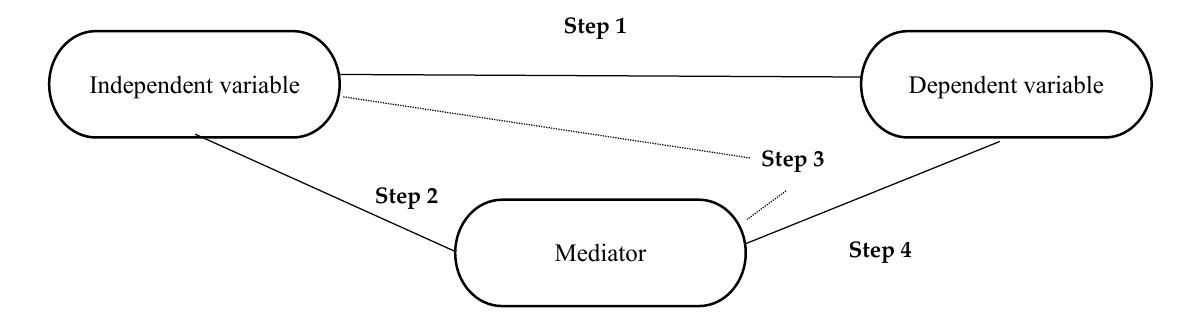
Figure 2. Mediator analysis according to Baron and Kenny [32].